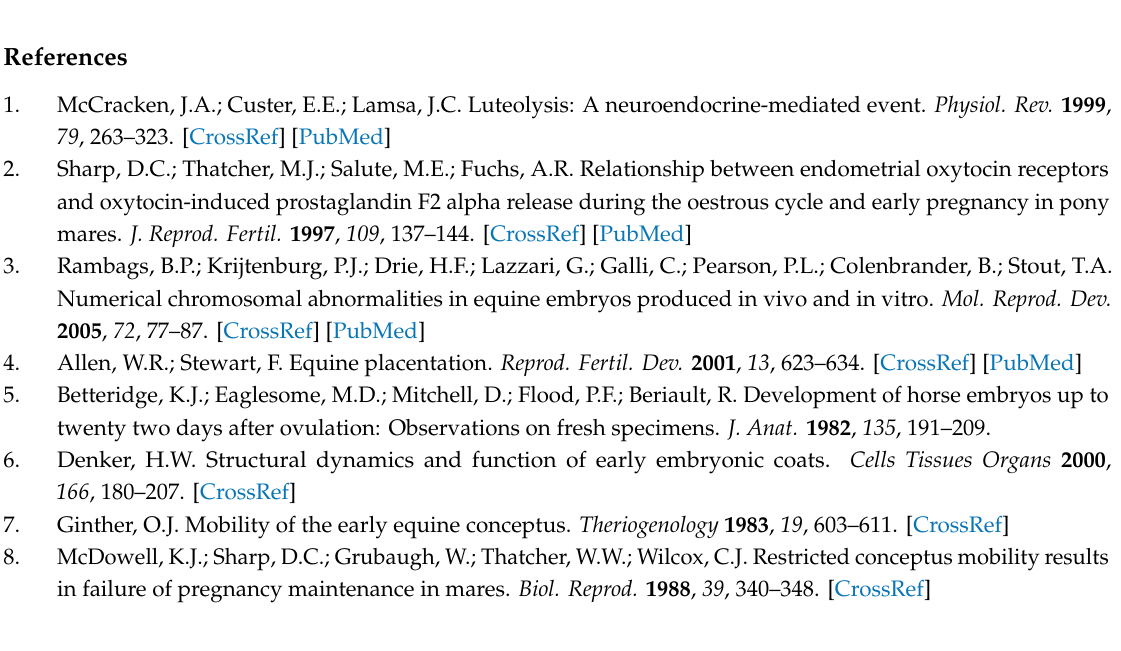
Table S1: All significant ncRNAs ( p ≤ 0.05; known and unknown) in equine endometrium from pregnant and non-pregnant mares on day 11 post-ovulation; Table S2: All Kegg pathways associated with the di ff erentially expressed miRNA on day 11 that were more abundant in samples from non-pregnant